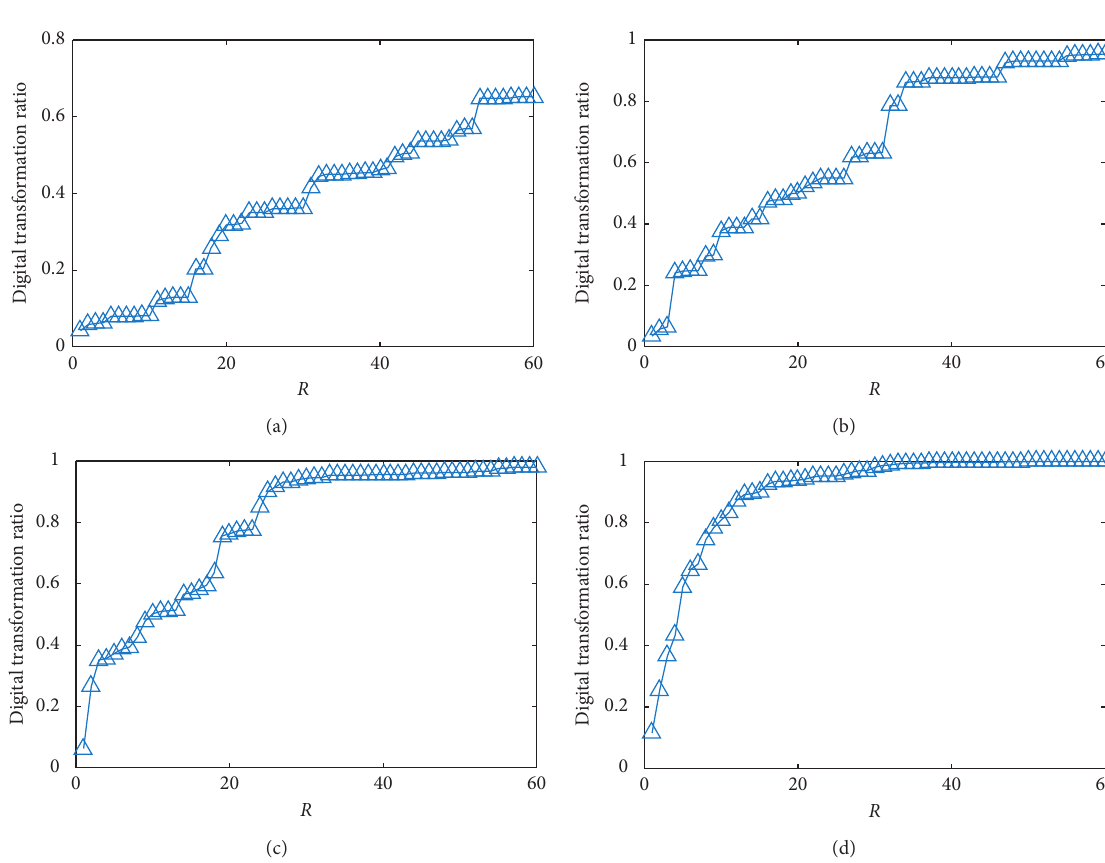
Figure 2: Proportions of enterprises carry out digital transformation under different transformation costs: (a) Cu � 2, Cb � 4; (b) Cu � 1.5, Cb � 3; (c) Cu � 1, Cb � 2; (d) Cu � 0.5, Cb �